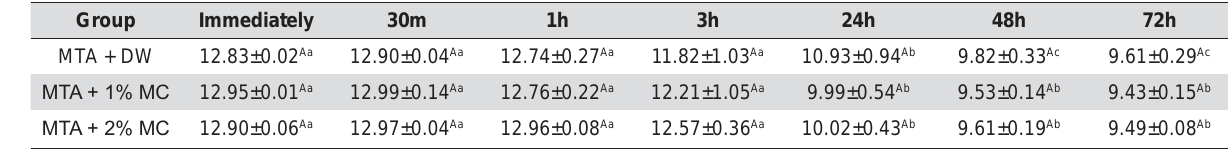
Table 2- Means and standard deviations of the pH of test materials at various time Group